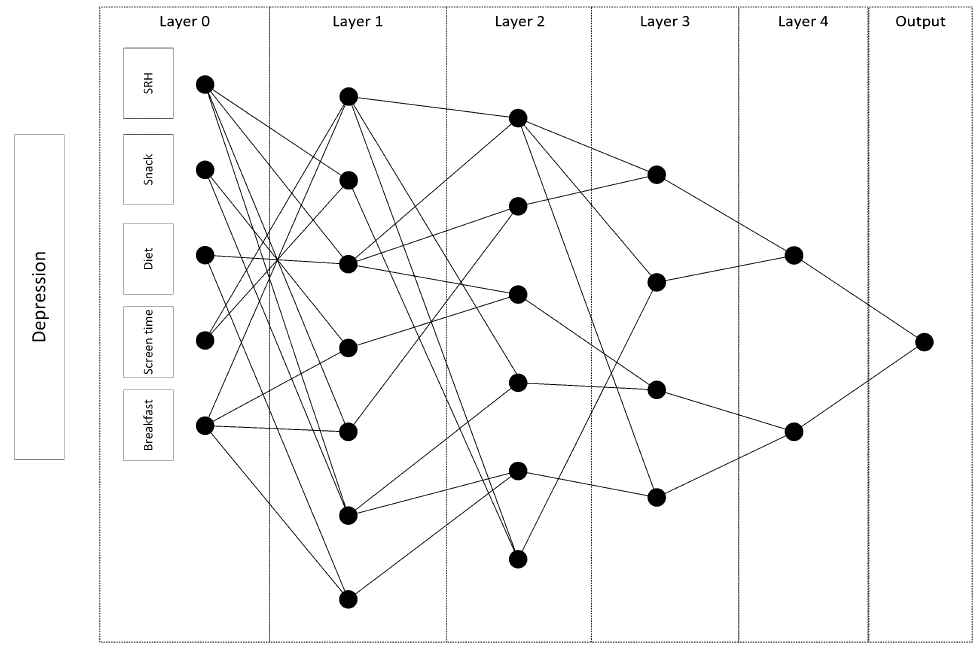
Figure 2. A representative GMDH network for classifying depression